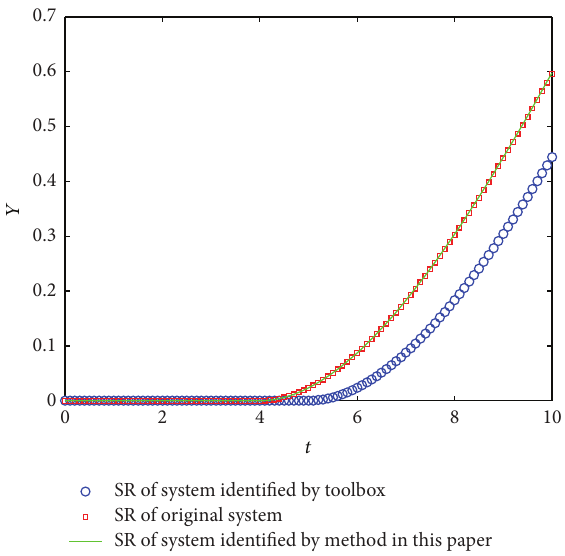
Table 2: Estimation of parameters.